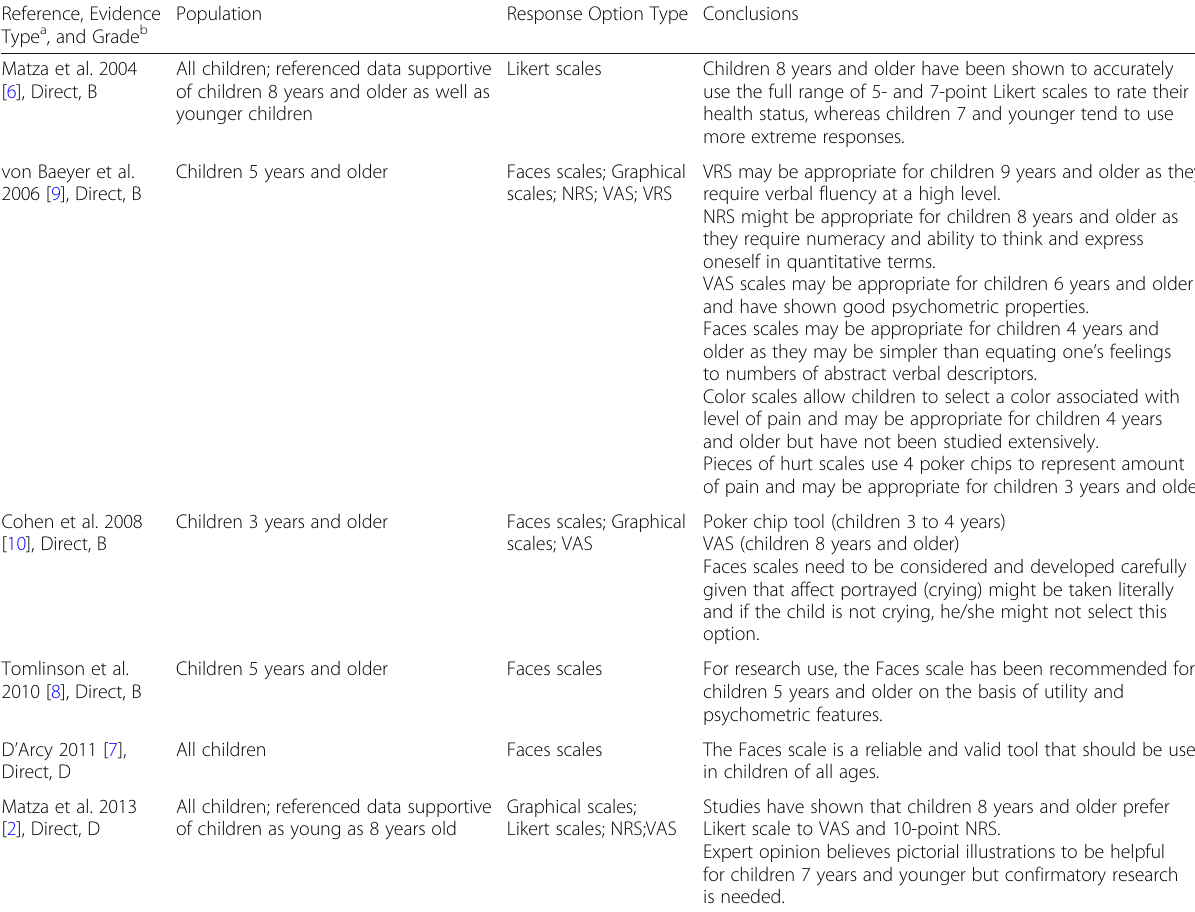
Table 2 Summary of Key Evidence to Support Response Scale Selection for the Pediatric Population Reference, Evidence Type a , and Grade